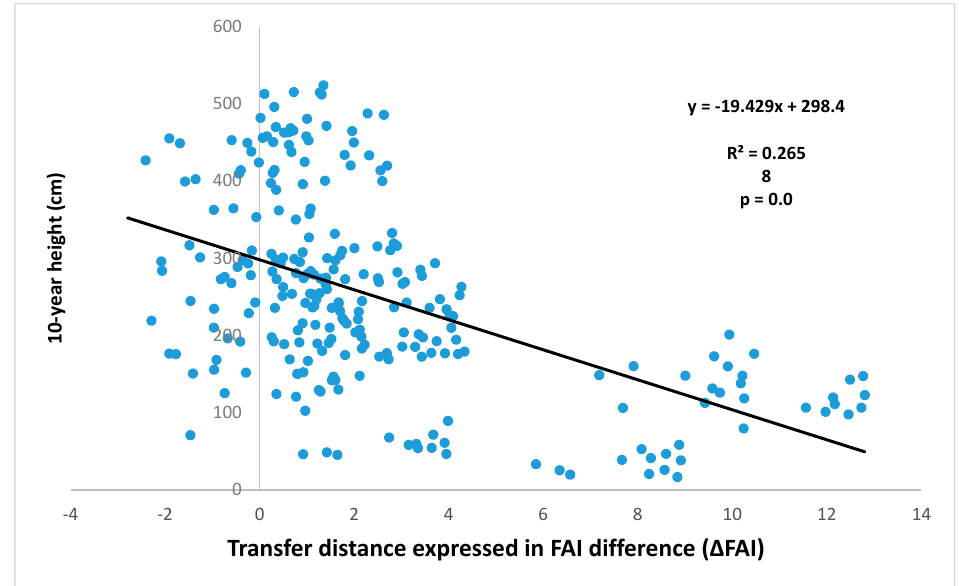
Figure 11. Regression of 10-year mean heights of 13 European populations of sessile oak vs. climatic transfer distance (ecodistance), expressed in FAI index difference ( Δ FAI) (design by Kóczán-Horváth see also [77]).